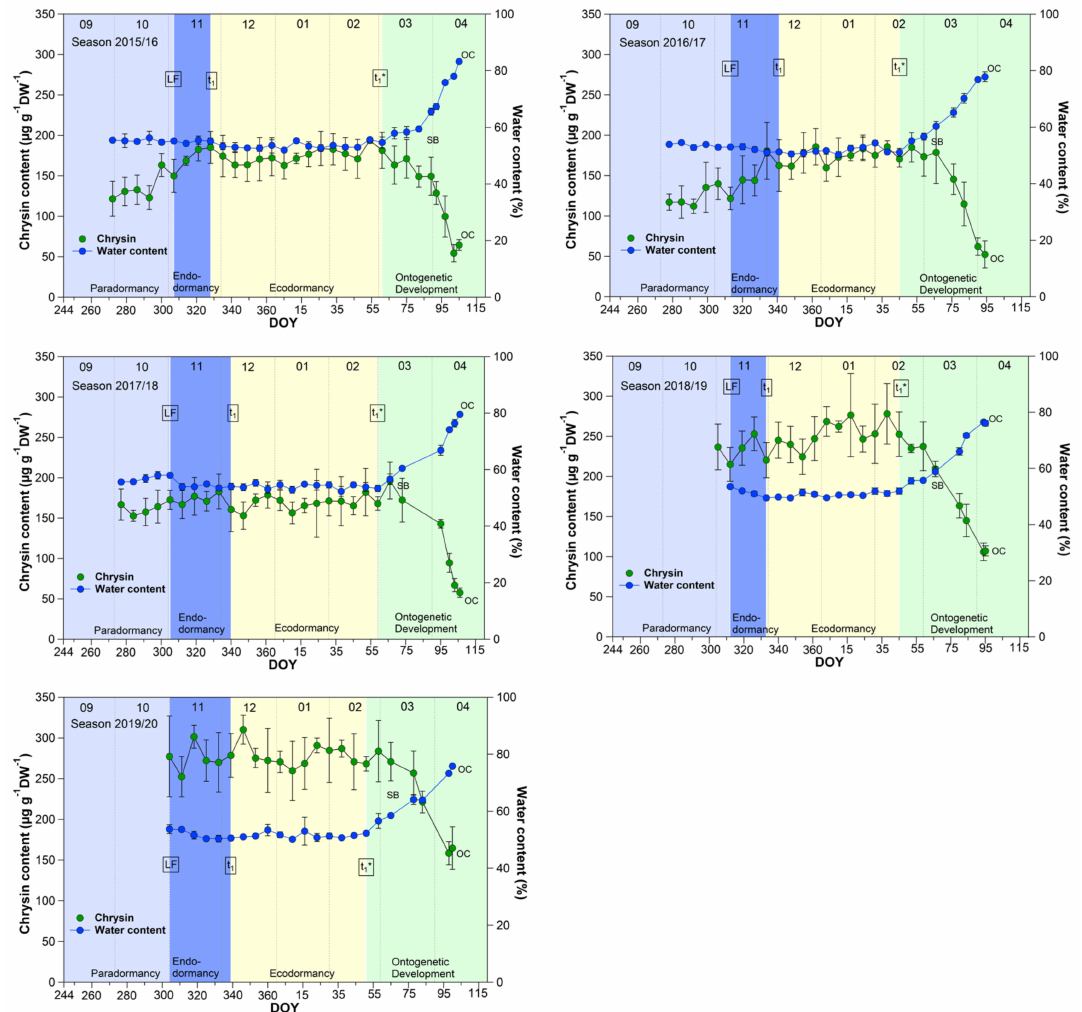
Figure 1. Chrysin and water content in sweet cherry buds cv. Summit, 2011/12–2019/20. ‘Total leaf fall’ (LF), endodormancy release (t 1 ), beginning of ontogenetic development (t 1 *), ‘swollen bud’ (SB) and ‘open cluster’